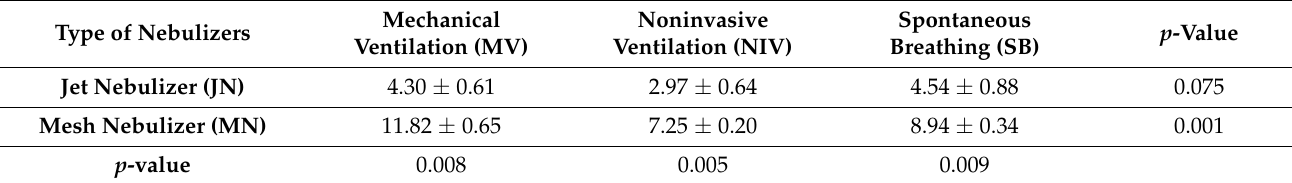
Table 1. Mean ( ± SD) percent dose delivered with jet and mesh nebulizers during mechanical ventilation, noninvasive ventilation, and spontaneous breathing in